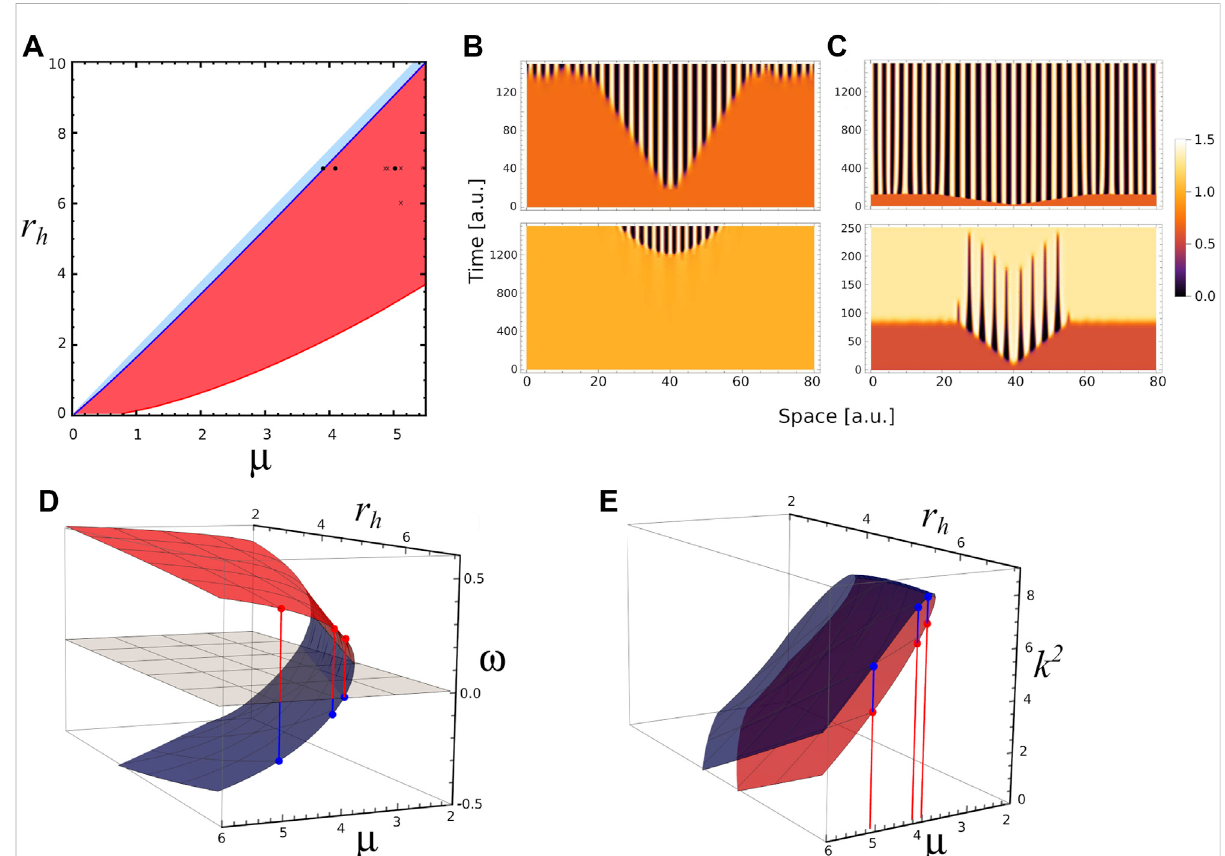
FIGURE 5 Different time scales. (A) 2D phase diagram shows the parameters region where the system presents stable Turing patterns (narrow blue area) and unstable or transient Turing patterns (blue area) for r a =2.5. Black dots correspond to different triplet of parameters values ( μ , r a , r h ) where numerical simulation were performed: P 1 =(3.9,2.5,7), in the Turing pattern region, P 2 =(4.1,2.5,7) and P 3 =(5.0,2.5,7) in the transient Turing pattern region. The crosses indicate parameters values used on Figure 6. (B) 1-D numerical simulations showing the temporal evolution of activator concentration distribution a for parameters value P 1 with two different initial conditions. Top (bottom) panel corresponds to the temporal evolution when fi xed point S 1 ( S 2 ) is perturbed by a small perturbation at x =40, note the different timescales on the panels. (C) 1-D numerical simulations showing the temporal evolution of a for parameters values P 2 (top panel) and P 3 (bottom panel) when the same fi xed point S 1 is perturbed at x =40, note the different timescales on the panels. (D) Red and blue surfaces correspond to ω -value as function of μ and r h ( r a =2.5) associated with fi xed points S 1 and S 2 , respectively. (E) k 2 -values as function of μ and r h associated with S 1 (red surface) and S 2 (blue surface). Red and blue dots indicate k 2 values for